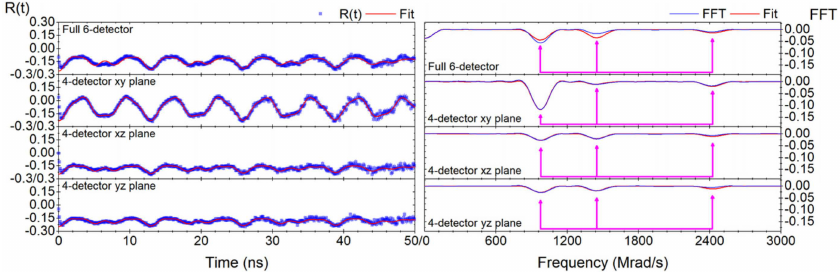
Figure 5. ( left ) R(t) graph and ( right ) corresponding FFT spectrum of the single γ − γ TDPAC measurement of 181 Ta(TiO 2 ) with four possible geometries. The TDPAC probe used is 181 Hf → 181 Ta, with the raw TDPAC spectrum (from the coincidence searches on the detectors) processed and converted into R(t) observables (see blue curves in R(t) and corresponding FFT graphs) by Interlude TM (Equations (2)–(5)). The R(t) signals are then fit using the Gfit19 TM program (see red curves in R(t) and the corresponding FFT graphs). For clarity, we show only the first 50 ns on the R(t) graph because shorter coincidence searches of γ − γ rays are less noisy and thus more statistically significant than longer coincidence